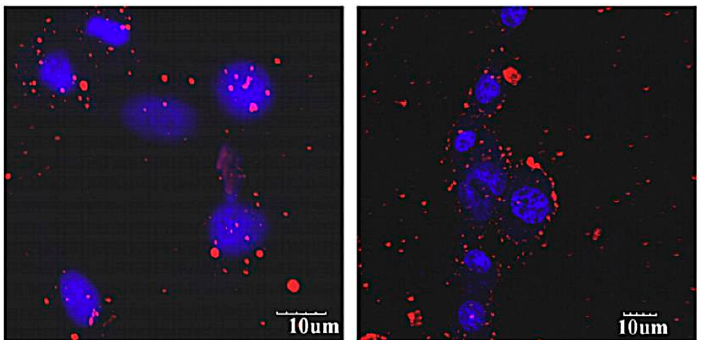
Figure 8. Field-emission transmission electron microscopy image of single quantum dots loaded-D-alpha-tocopheryl polyethylene glycol 1000 succinate mono-ester (TPGS)-coated liposome in a 100 nm scale. Red intensity referred to quantum dots (QDs) and blue for nuclei. This image was reproduced with permission from [92]. Copyright©, 2012, Elsevier BV.